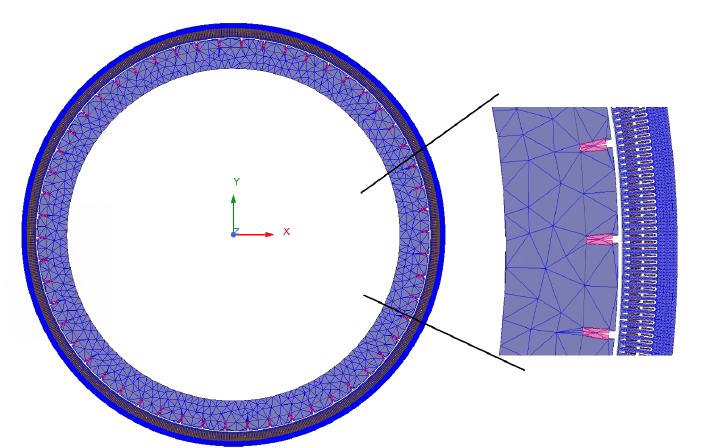
Figure 7. The mesh of the rotor eccentricity model with 0.15 mm